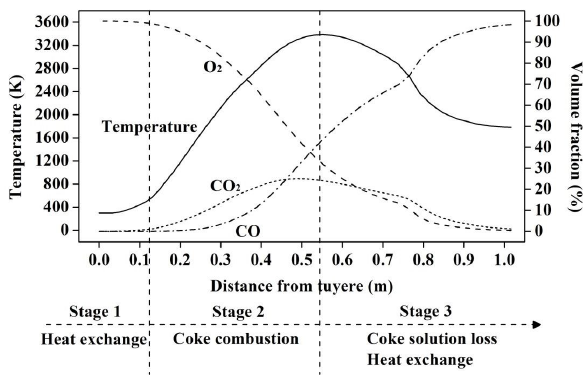
Figure 5: Radial distribution of gas temperature and species along tuyere